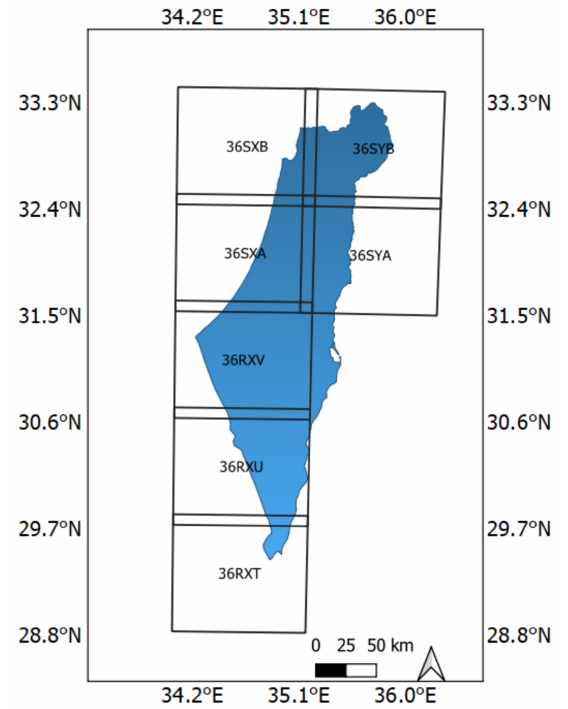
Figure 1. Sentinel-2 tiles over